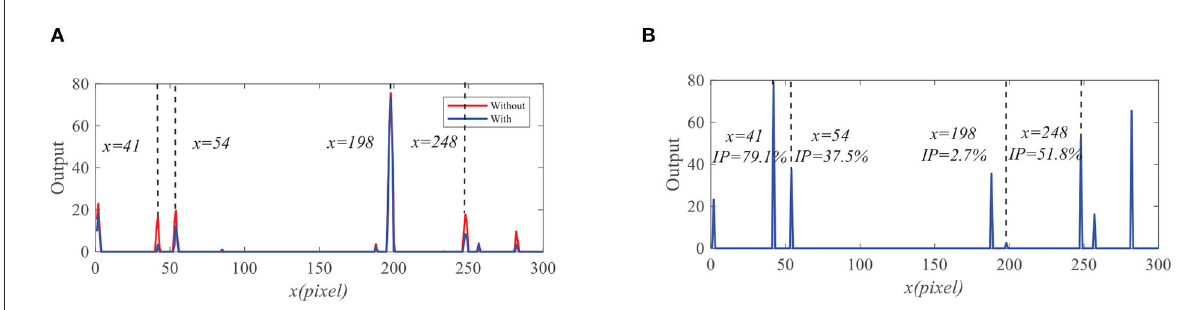
TABLE 2 Details of the synthetic image sequences.